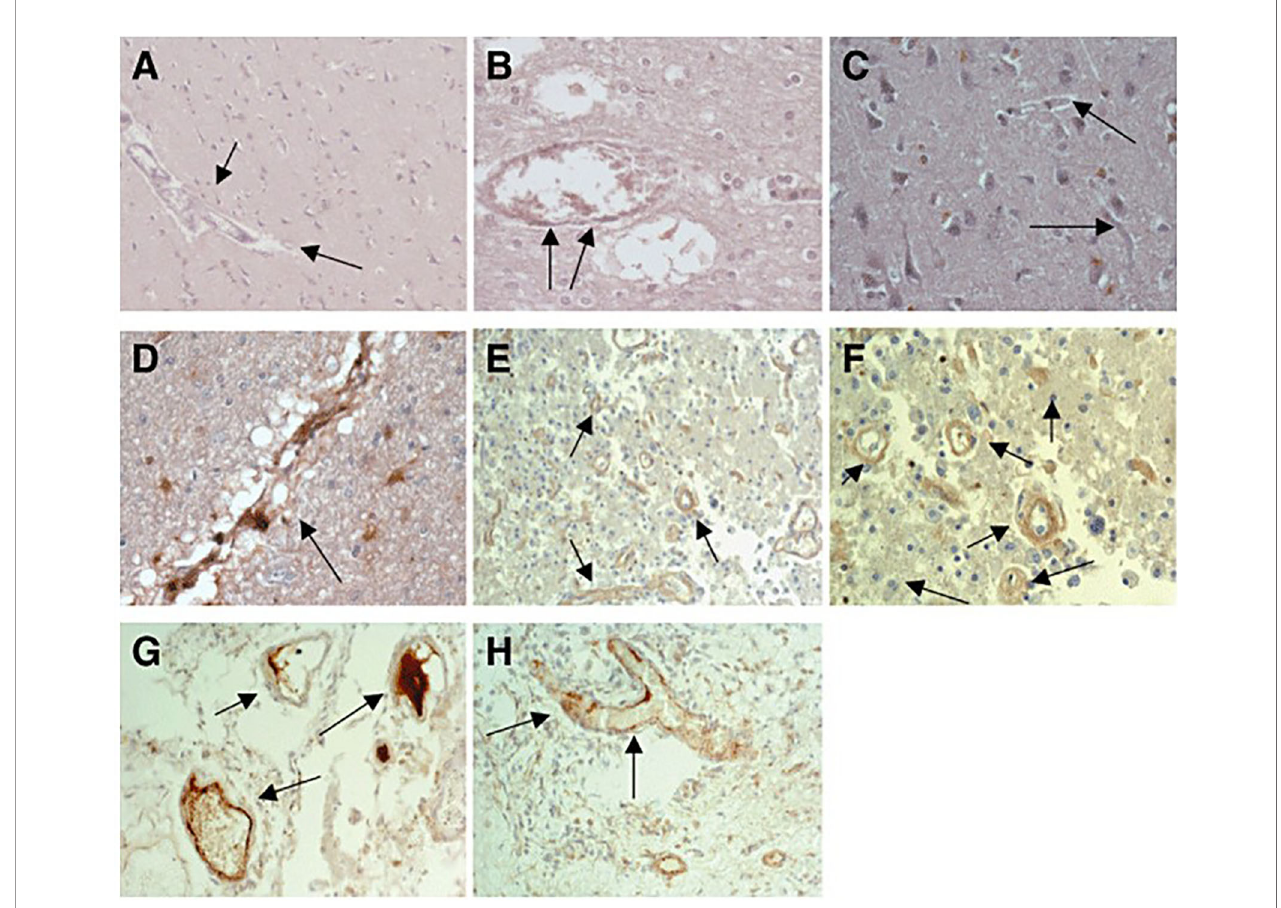
FIGURE 1 | (A) Expression of native C ‐ reactive protein (nCRP) in contralateral brain tissue: almost no expression of nCRP was seen in blood vessels and neurons from normal looking brain tissue [arrows mark the blood vessels; 3,3 ′ ‐ diaminobenzidine ‐ tetrachloride (DAB) brown development; Patient 17]. (B) Expression of nCRP in peri ‐ infarcted brain tissue again showing no notable expression, apart from occasional staining within the lumen of larger vessels (arrows; DAB brown development; Patient 17). (C) Expression of monomeric form of CRP (mCRP) in contralateral brain tissue: almost no expression of mCRP was seen in normal looking brain tissue (arrows mark the blood vessels; DAB brown development). mCRP was abundantly expressed in peri ‐ infarcted (D – F) and infarcted (G, H) brain tissue particularly in microvessels (marked by arrows; DAB brown development). Taken from Reference